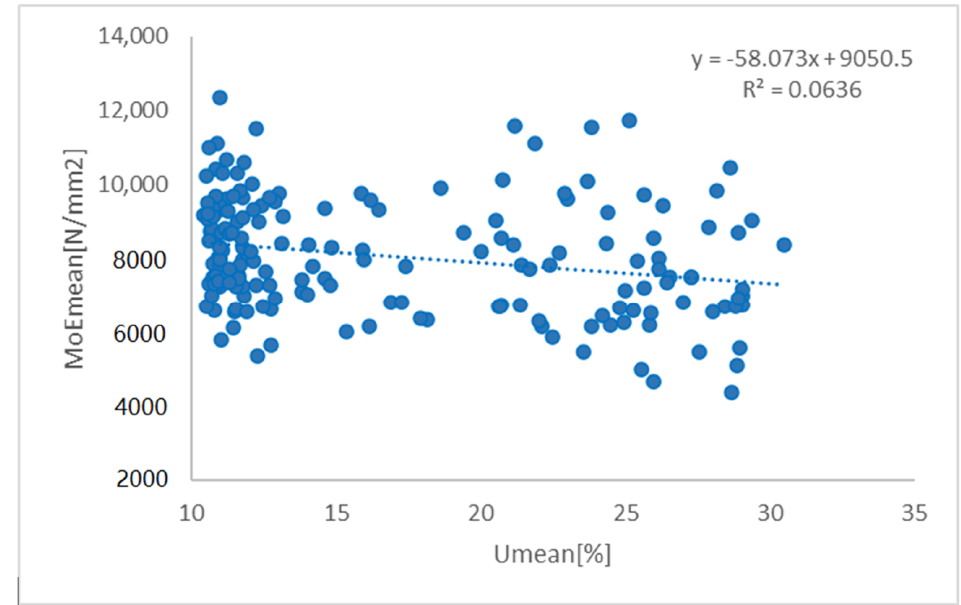
Figure 6. MoE dyn variation with moisture content U.